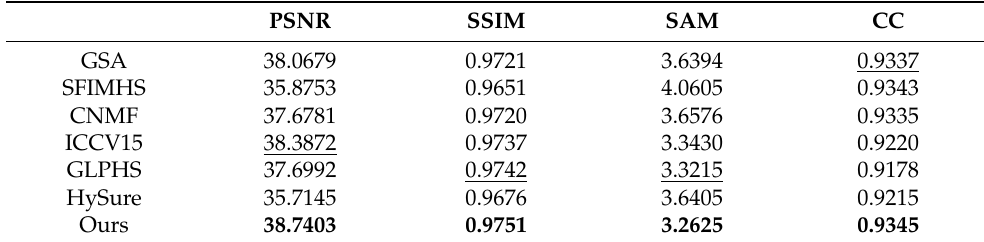
Table 2. Quantitative evaluation results of Pavia University dataset with simulated multispectral images.